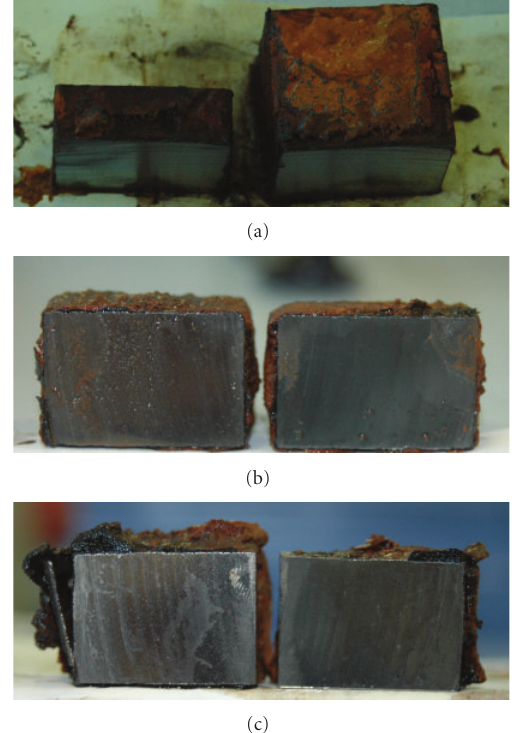
Figure 5: Corrosion products after 6 months after